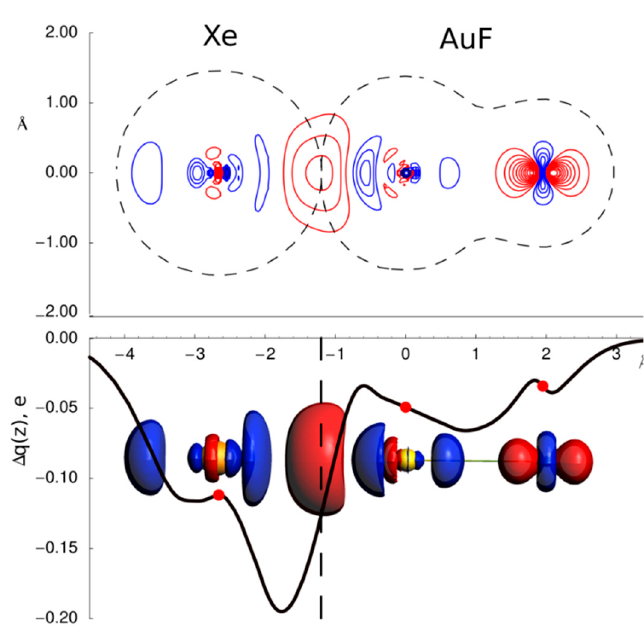
Figure 1. Contour plots of the electron density difference between XeAuF molecules and the Xe and AuF fragments. The positive contour levels (red) range from 0.005 to 0.2 e/bohr 3 with a step of 0.005, while the negative ones (black) range from − 0.005 to − 0.2 e/bohr 3 with a step of 0.005. In the bottom part the integrated charge displacement function Δ q (see text) is reported as a function of the internuclear distance. The 3D isodensity plot of the electronic charge due to the intermolecular interaction (cutoff = ± 0.005 e/bohr − 3 , with negative/positive values in blue/red).